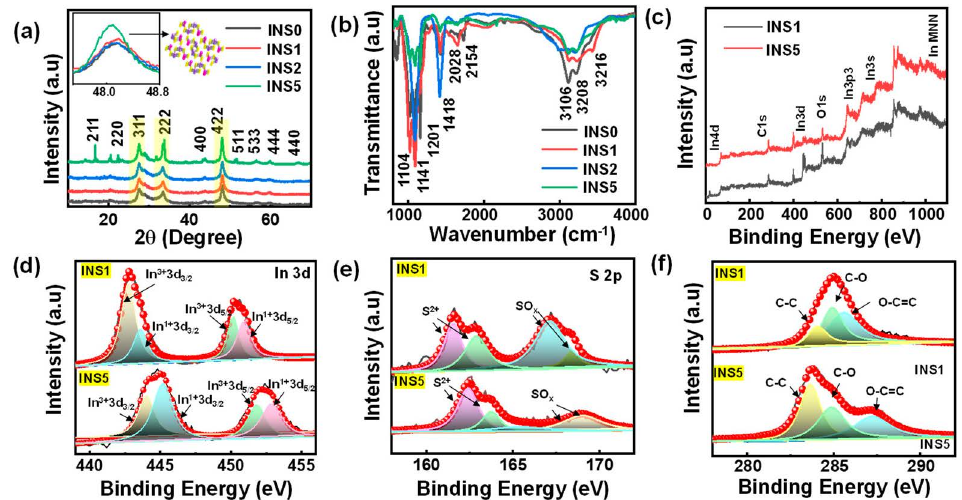
Figure 2. ( a ) XRD patterns, ( b ) FTIR spectra, ( c ) XPS survey spectrum, ( d ) high-resolution, In 3d XPS spectra, ( e ) high-resolution S2p spectra, and ( f ) high-resolution C spectrum of INS1 and INS5 sam- ples.